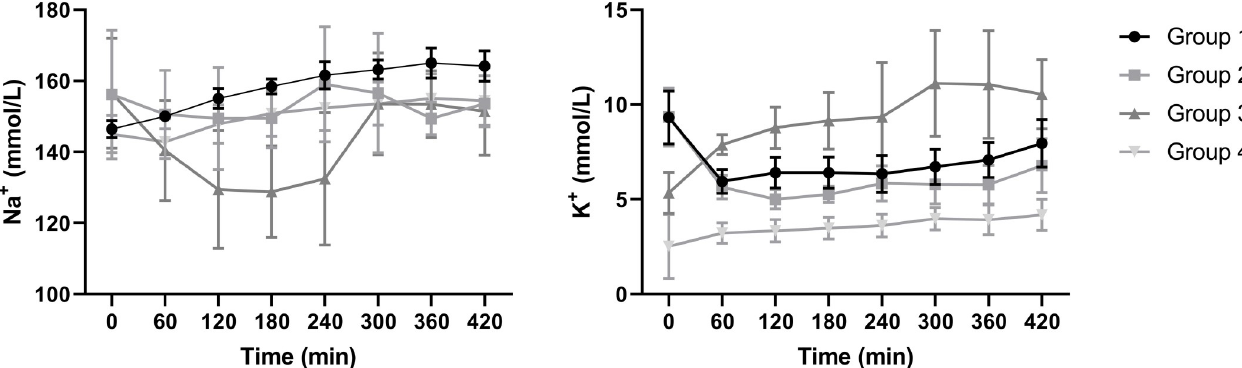
Fig 4. Sodium and potassium levels (mmol/L) of the four experimental groups during NMP (mean + SD).